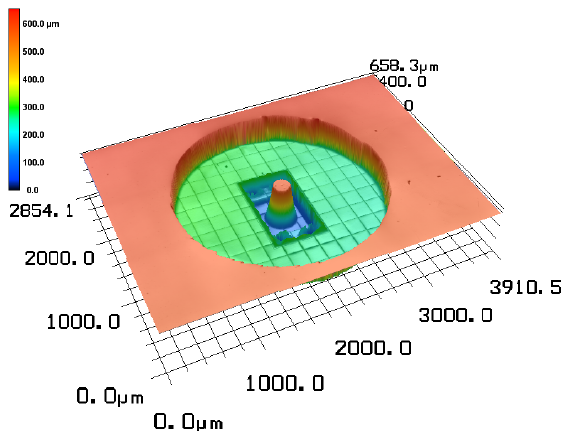
Figure 10. Metrology of the gripper head mould in polydimethylsiloxane